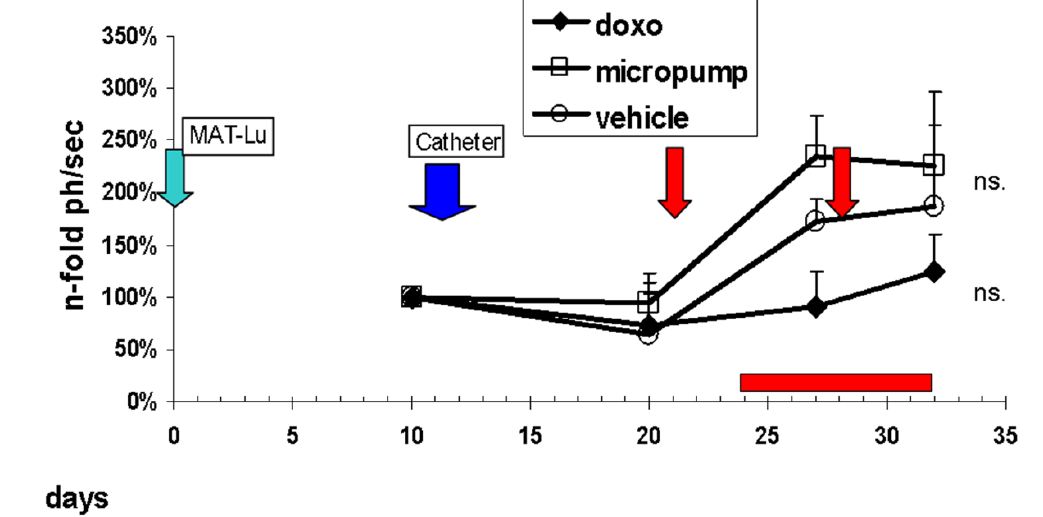
Figure 5. Anti-tumor effects of intravenous metronomic micropump-mediated doxorubicin application in the subcutaneous MAT-Lu model. Tumor growth was followed up by in vivo bioluminescence image-analysis in a Nightowl LB981 camera system (Berthold, Bad- Wildbach, Germany) starting with day 10 after tumor implantation (green arrow). Catheter embedment was performed between days 12 and 14 (blue arrow) in 9 animals. Metronomic application (micropump) of daily 0.1 mg/kg doxorubicin (□) was given from day 24 until day 32 (red bar at bottom). The experiment was terminated on day 32 after tumor implantation (final tumor volume 17.3 ± 4.6 cm 3 ). At day 21, followed by day 28, control treatments (red arrows) were started with bolus injection of 1mg/kg doxorubicin (  ) in 9 animals or the vehicle (○) in 10 animals (these groups were not sham operated). Green arrow (MAT-Lu) = tumor implantation; blue arrow (Catheter) = catheter embedment; red arrows = doxorubicin bolus injection; red bar = metronomic doxorubicin